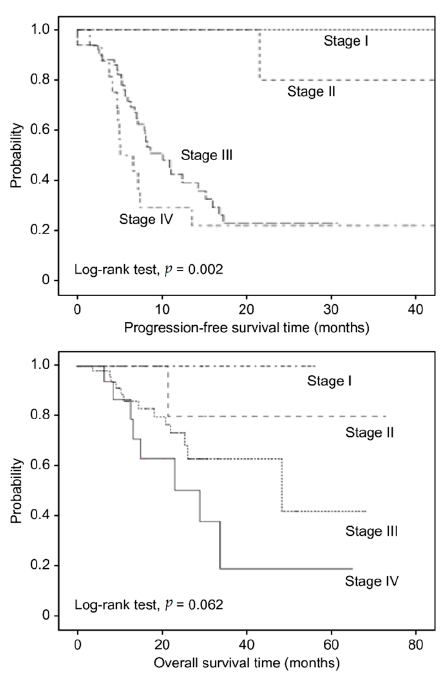
Figure 3. ( A ) Kaplan-Meier analysis of progression-free survival time in EOC patients receiving BEV therapy based on AIM2, C3 and C5 IHC staining scores. ( B ) Kaplan-Meier analysis of overall survival time in EOC patients receiving BEV therapy based on AIM2, C3 and C5 IHC staining scores.